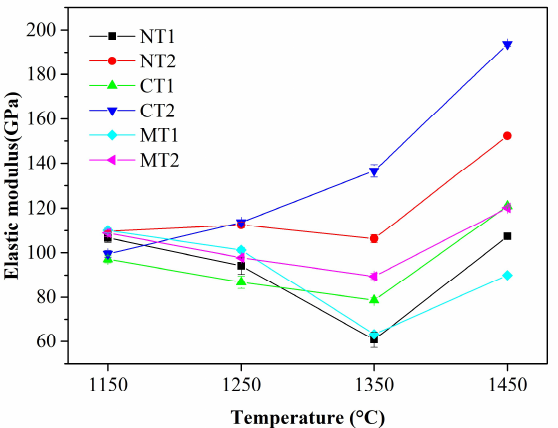
Figure 9. Variation of elastic modulus for the castables with calcination temperatures.